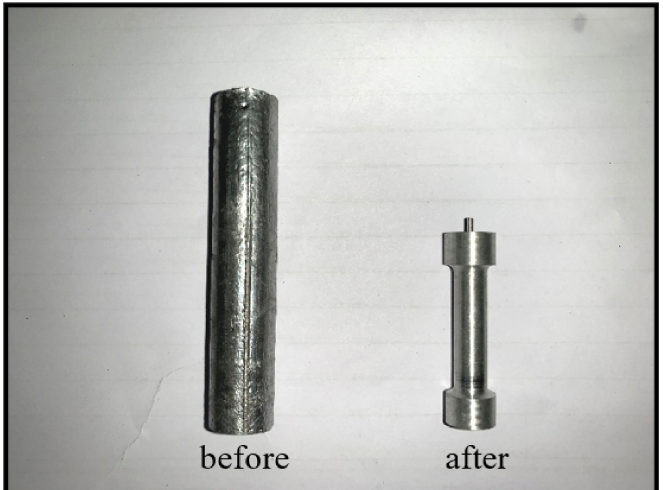
Figure 5. Tensile sample before and after machining as per the standards.